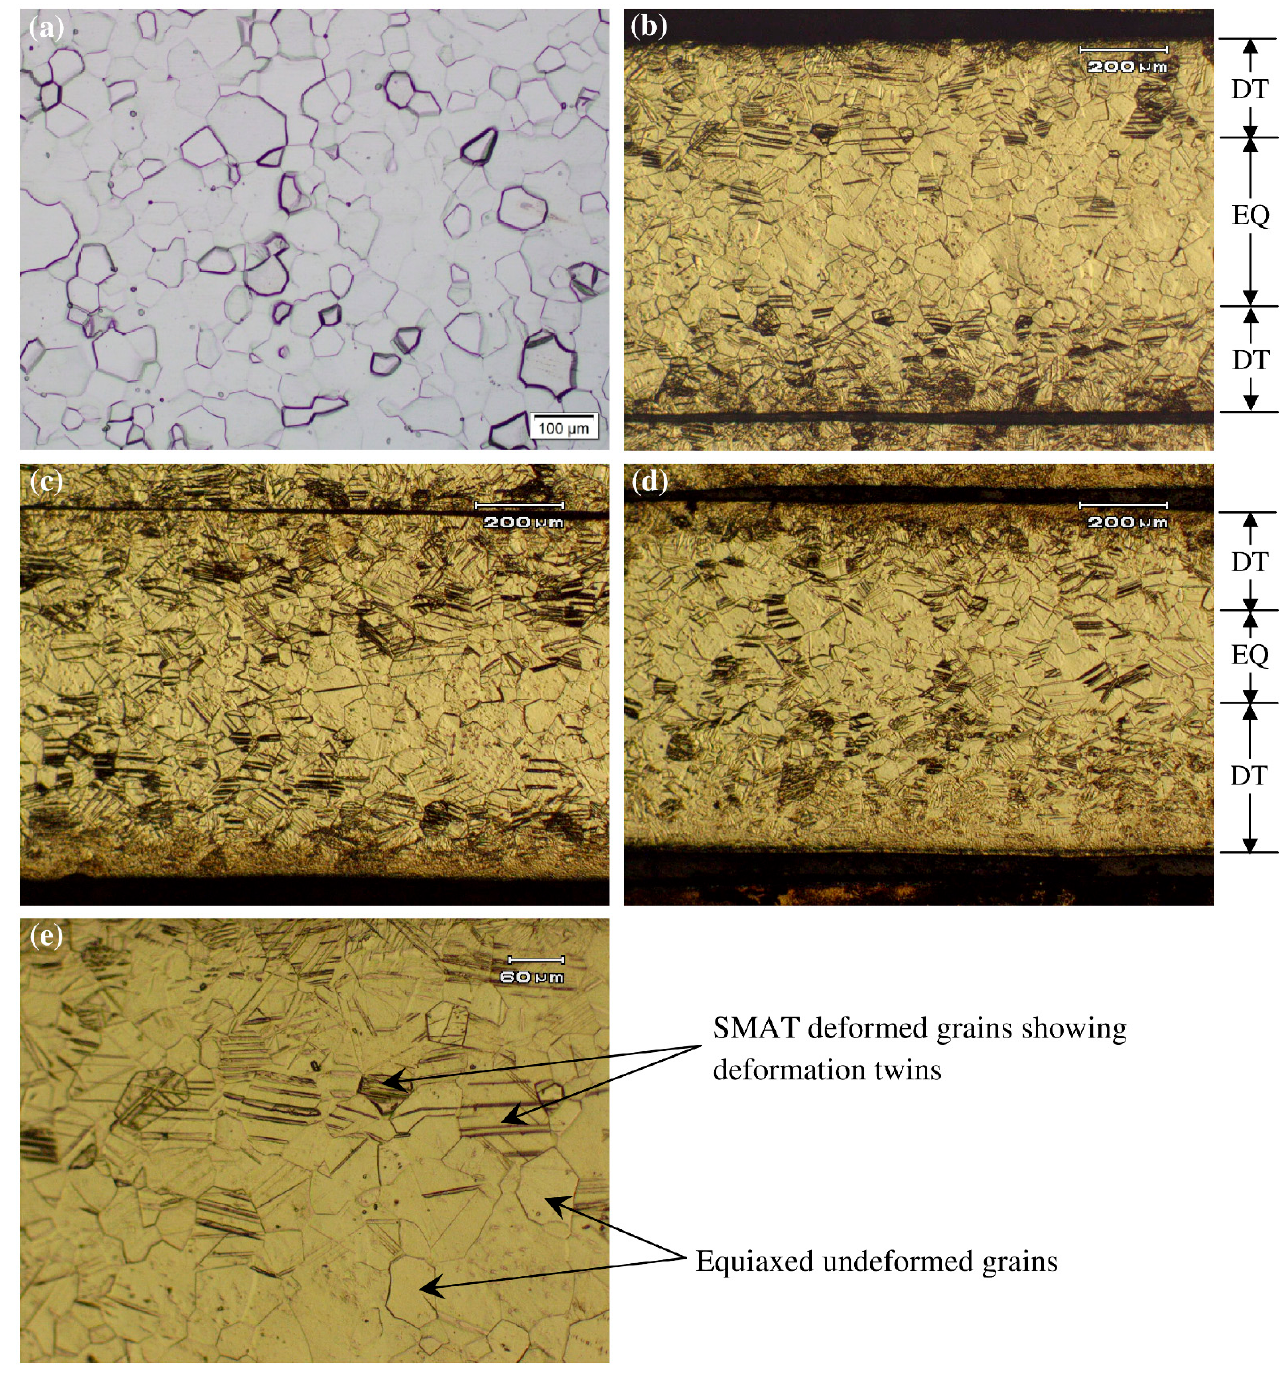
Figure 3. Optical microstructures of: ( a ) untreated Ti with equiaxed grains; SMAT-modified samples treated for: ( b ) 15 min; ( c ) 20 min and ( d ) 25 min showing twined structure at both surfaces and undeformed equiaxed grains at the center; ( e ) SMAT deformed and undeformed equiaxed grains at higher magnification. DT and EQ stand for deformation twins and equiaxed grains.